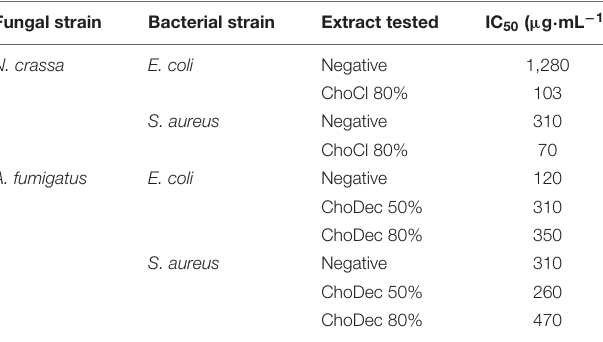
TABLE 2 | IC 50 values determined for A. fumigatus and N. crassa crude extracts from media supplemented or not (negative control) with choline chloride (ChoCl) or choline decanoate (ChoDec), at 50 or 80% of the